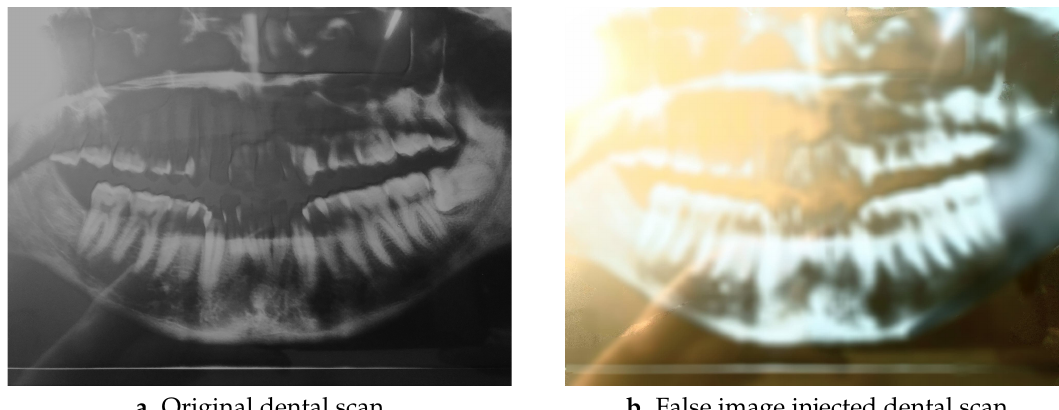
Figure 2. An example of a false image injection attack.